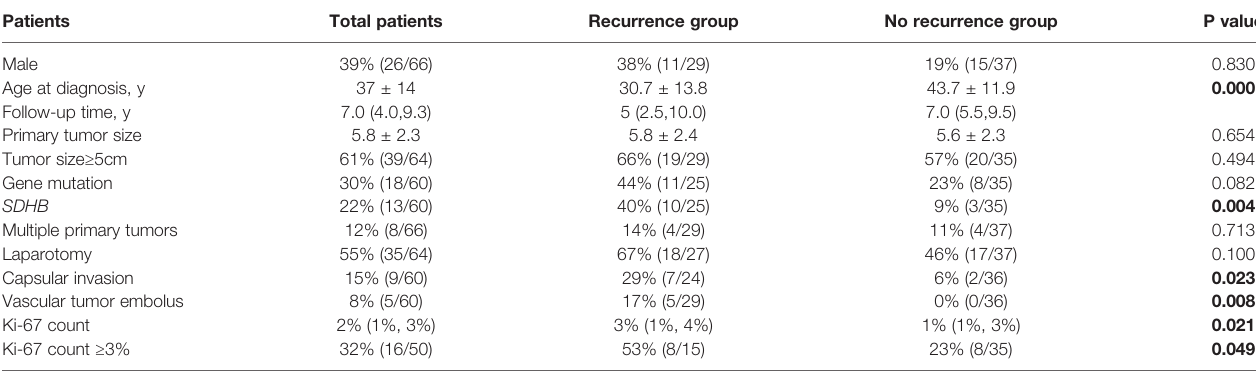
TABLE 4 | Clinical characteristics of paraganglioma with and without recurrence. Patients